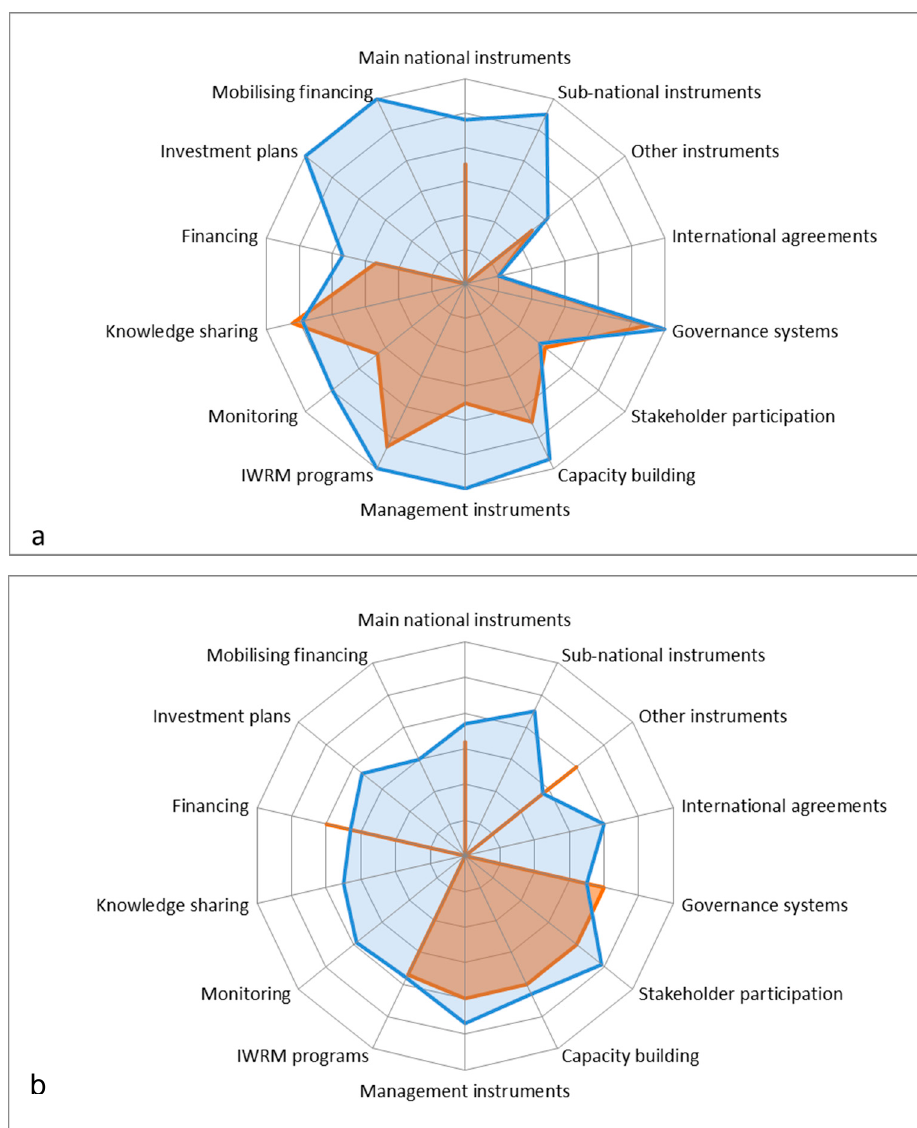
Figure 2. Integrated Water Resources Management (IWRM) implementation: ( a ) Australia; ( b ) Brazil. Orange: 2007; Blue: 2011. Source: UNEP [33].